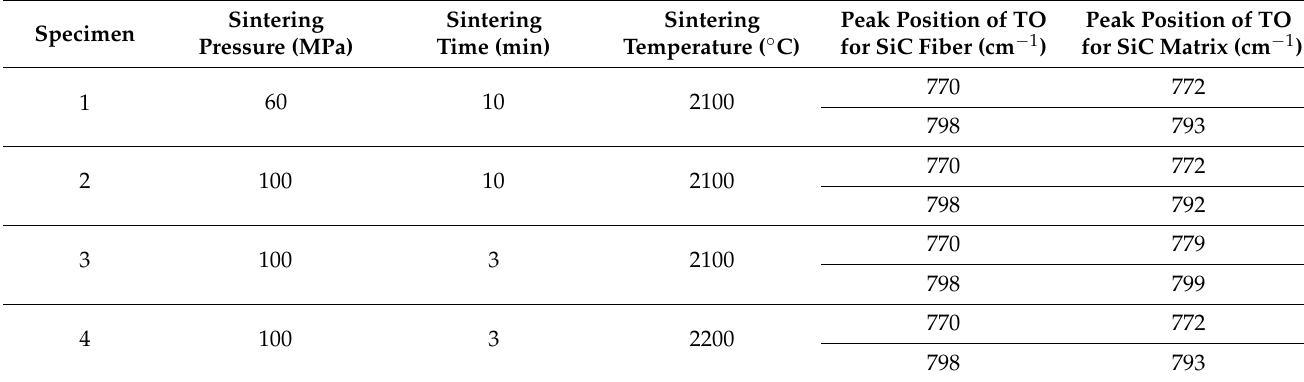
Table 3. Peak position of the TO vibration mode of the preceramic paper-derived SiC f /SiC composites.